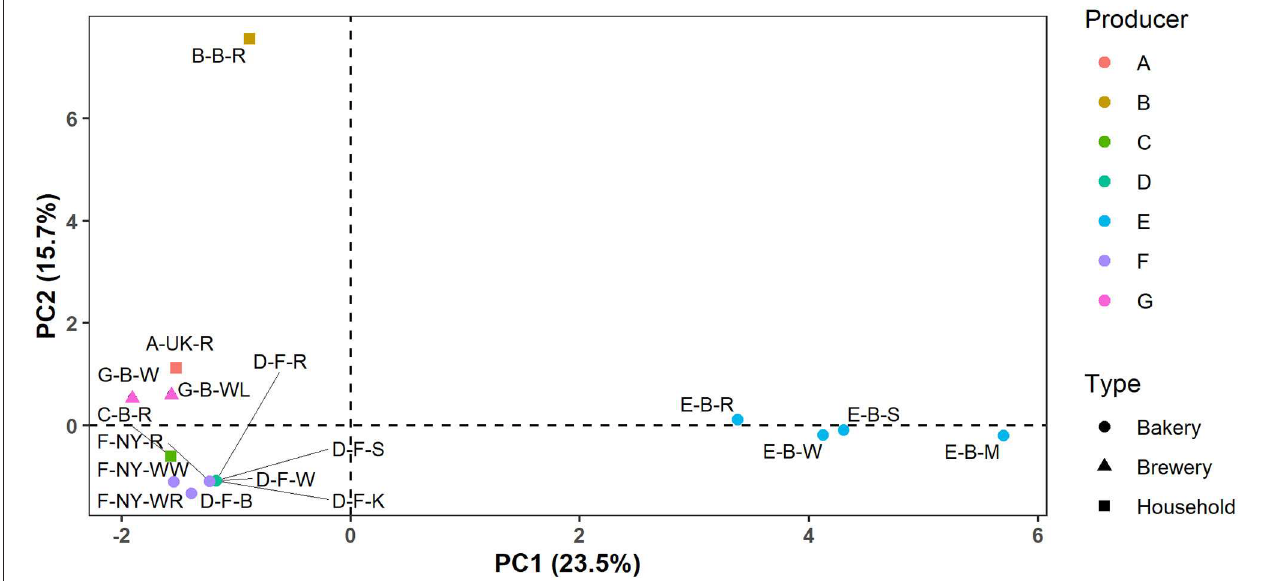
FIGURE 2 | Principal component analysis (PCA) of the normalized culture-dependent lactic acid bacterial, acetic acid bacterial, and yeast species diversity data of 17 sourdough samples from backslopped sourdoughs of different origins. The sample codes are as described in Table 1 .